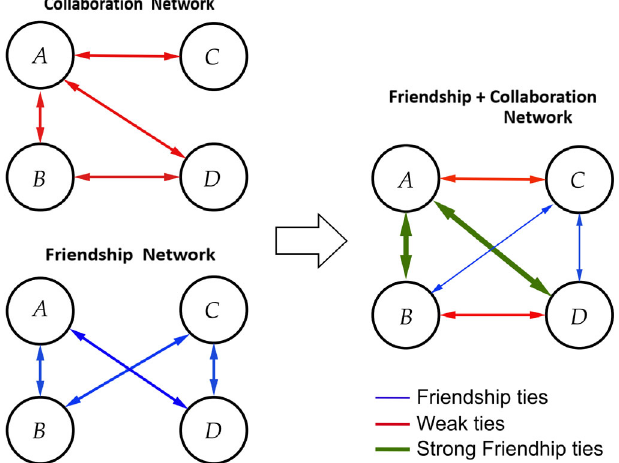
FIG. 1. Depiction of the methodology utilized to identify and construct collaborative variables number 2, 3, 4, and 5 described in Table III.